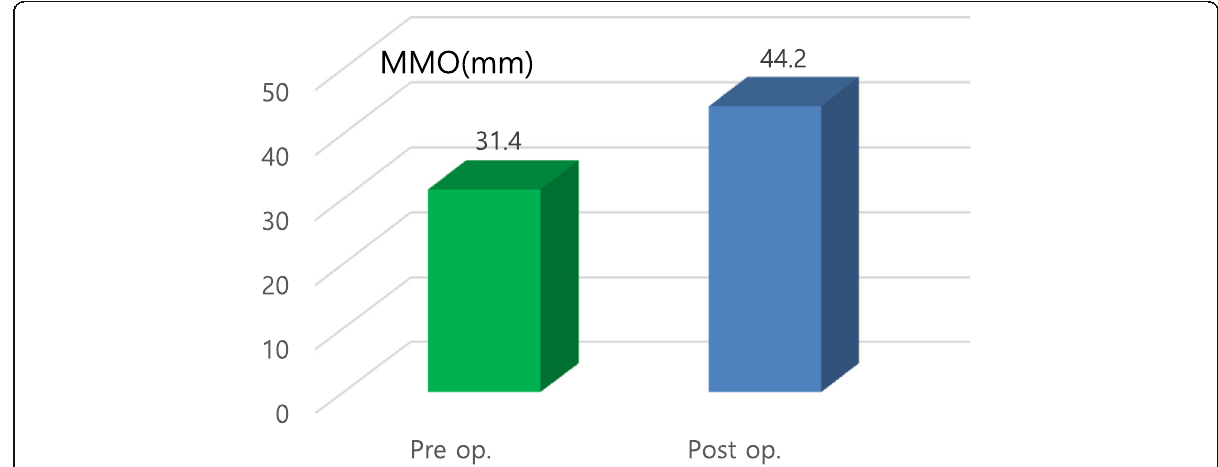
Fig. 13 Evaluation of preoperative (Pre op.) and postoperative (Post op.) average MMO in trismus patients ( n =